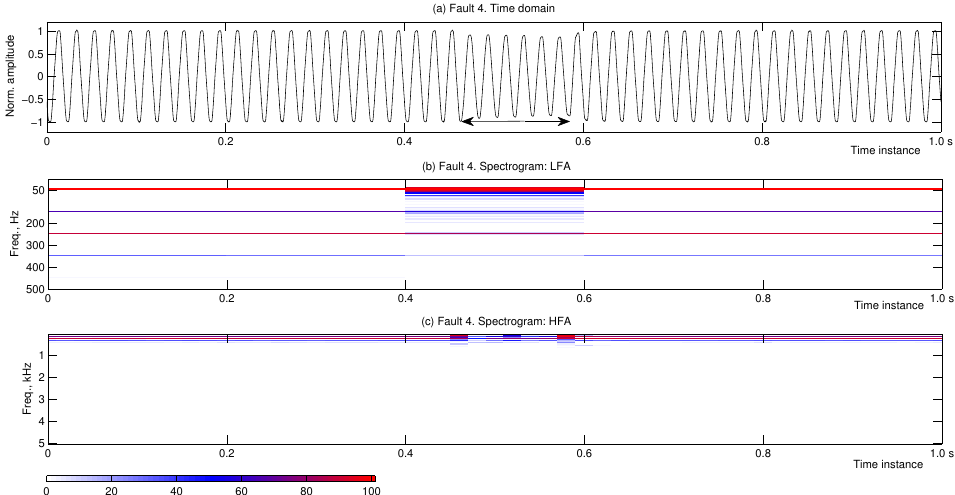
Figure 6. Fault #4: A sag with a remaining RMS voltage of 80%. The HFM output demarcates the beginning and the end of the